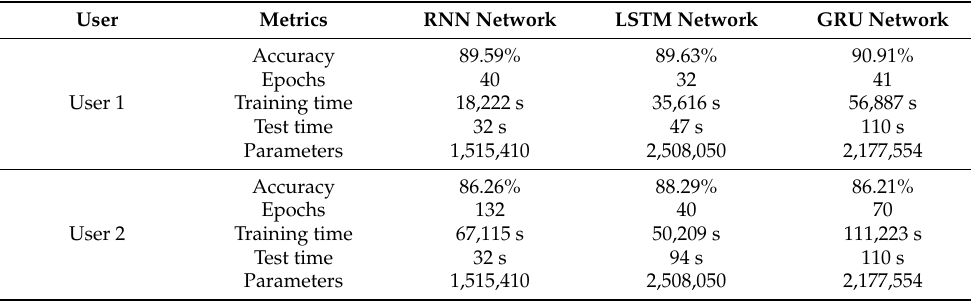
Table 5. Summary of neural network training for both